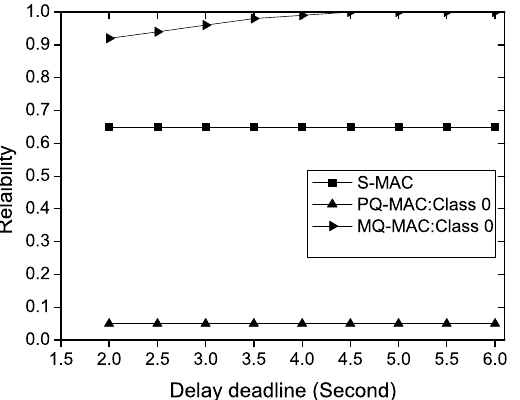
Figure 12. Reliability for different delay